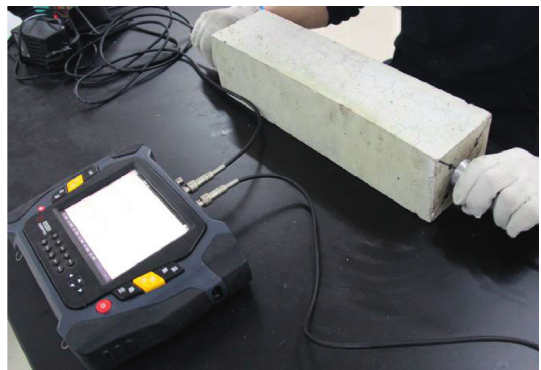
Figure 4: Ultrasonic wave velocity test of DSC.